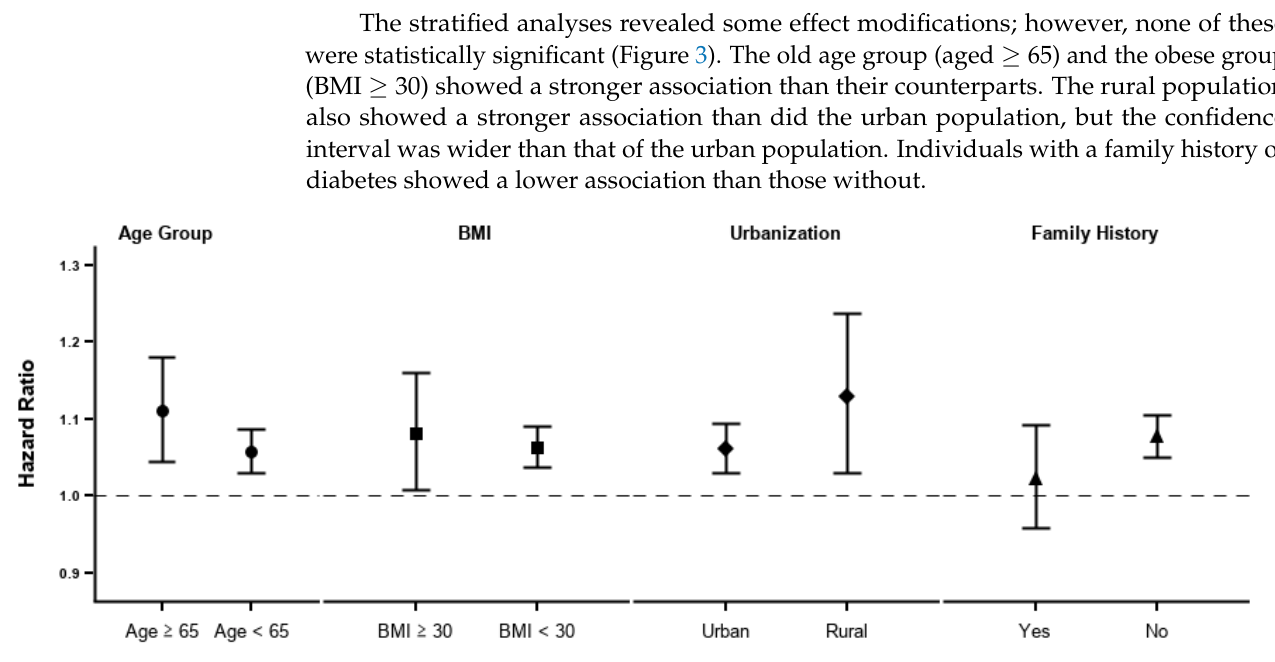
Figure 3. Stratified analysis by age group, obesity, residence, and family history.